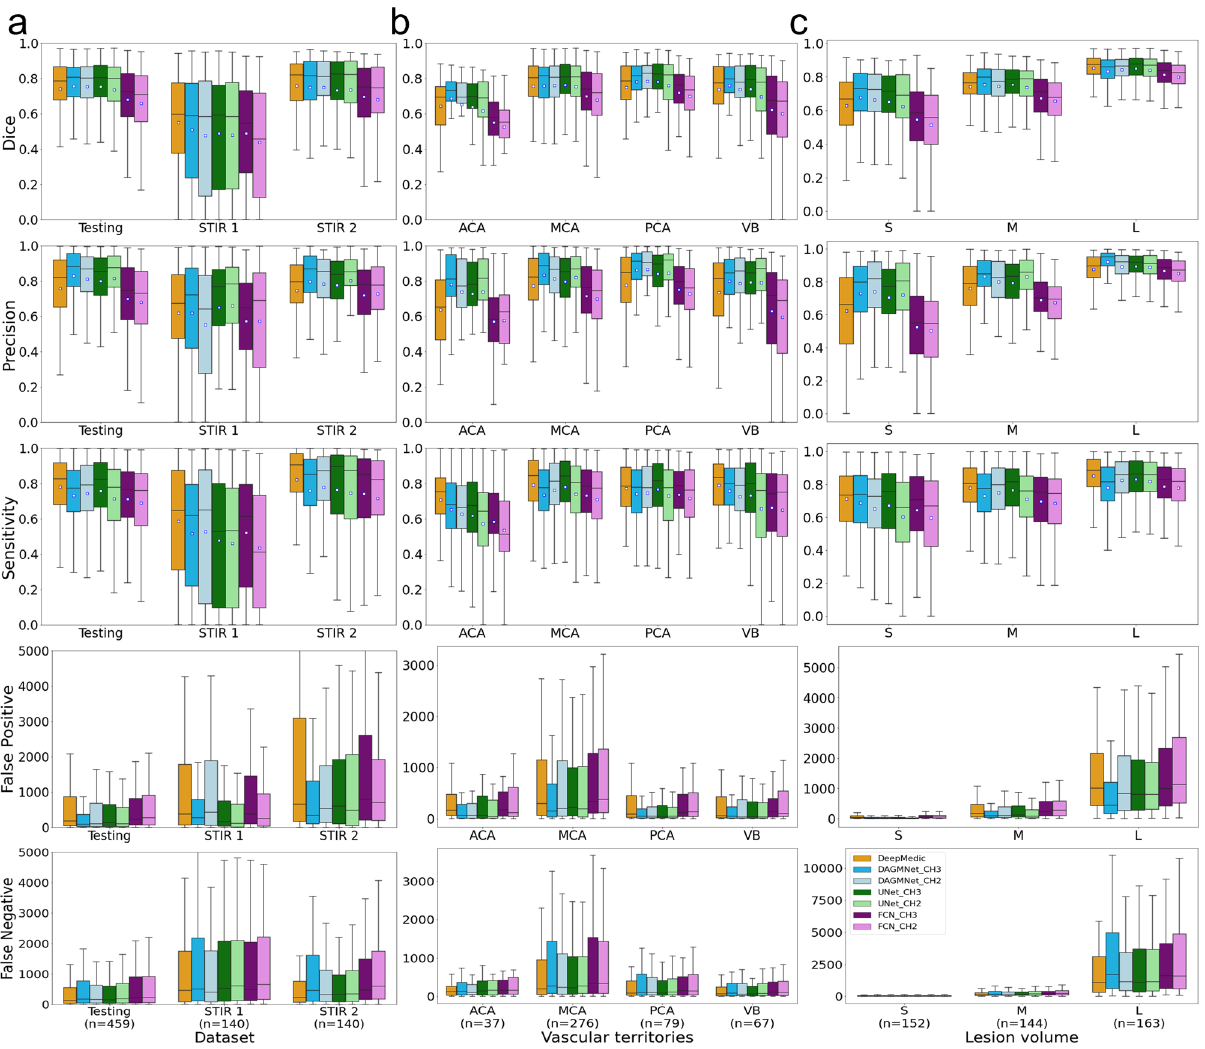
Fig. 3 Performance of all models (DeeMedic, DAGMNet, UNet, FCN). The performance is shown according to testing dataset ( a ), vascular territory ( b ), and lesion volume ( c ), S: small, M: medium, L: large. In each Whisker ’ s boxplot, the white square indicates the average; the black trace indicates the median. The whisker is a representation of a multiple (1.5) of the interquartile range (IQR). False-positive and false-negative are in units of voxels, in the original image space. All the sub- fi gures share the same legend as in sub- fi gure ( c